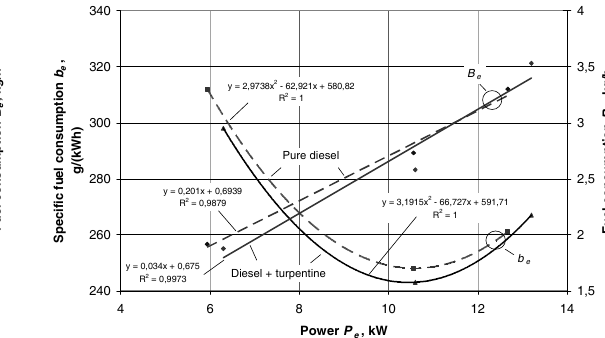
Fig 2. Dependence of fuel consumption on the engine torque for run at speed of 2 200 min –1